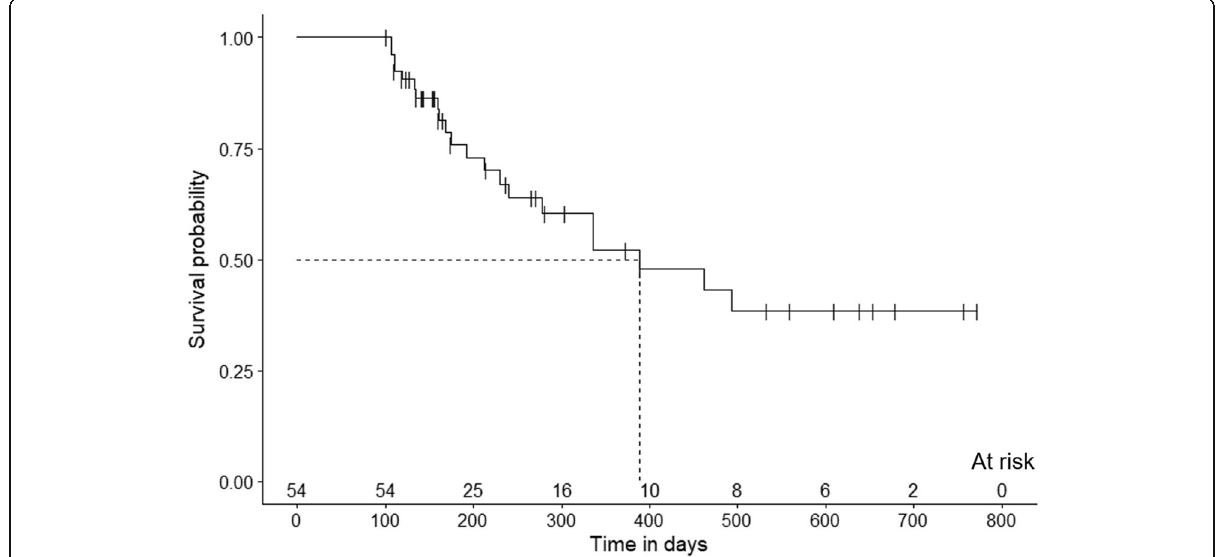
Fig. 2 The survival curve of remission of post-RCVS